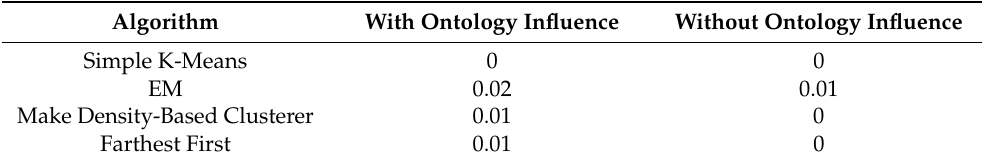
Table 2. Time in seconds to build the model on Real Reviews